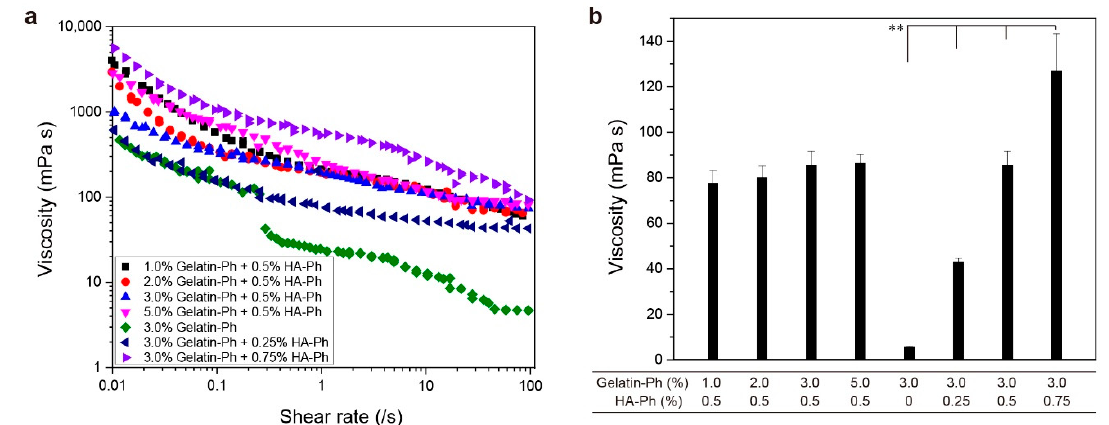
Figure 2. ( a ) Effects of gelatin-Ph and HA-Ph content on the viscosity profiles of solutions as a function of the shear rate. ( b ) The viscosity of solutions at a 45 s − 1 shear rate. Bars: S.D. ( n = 4). ** p < 0.01.